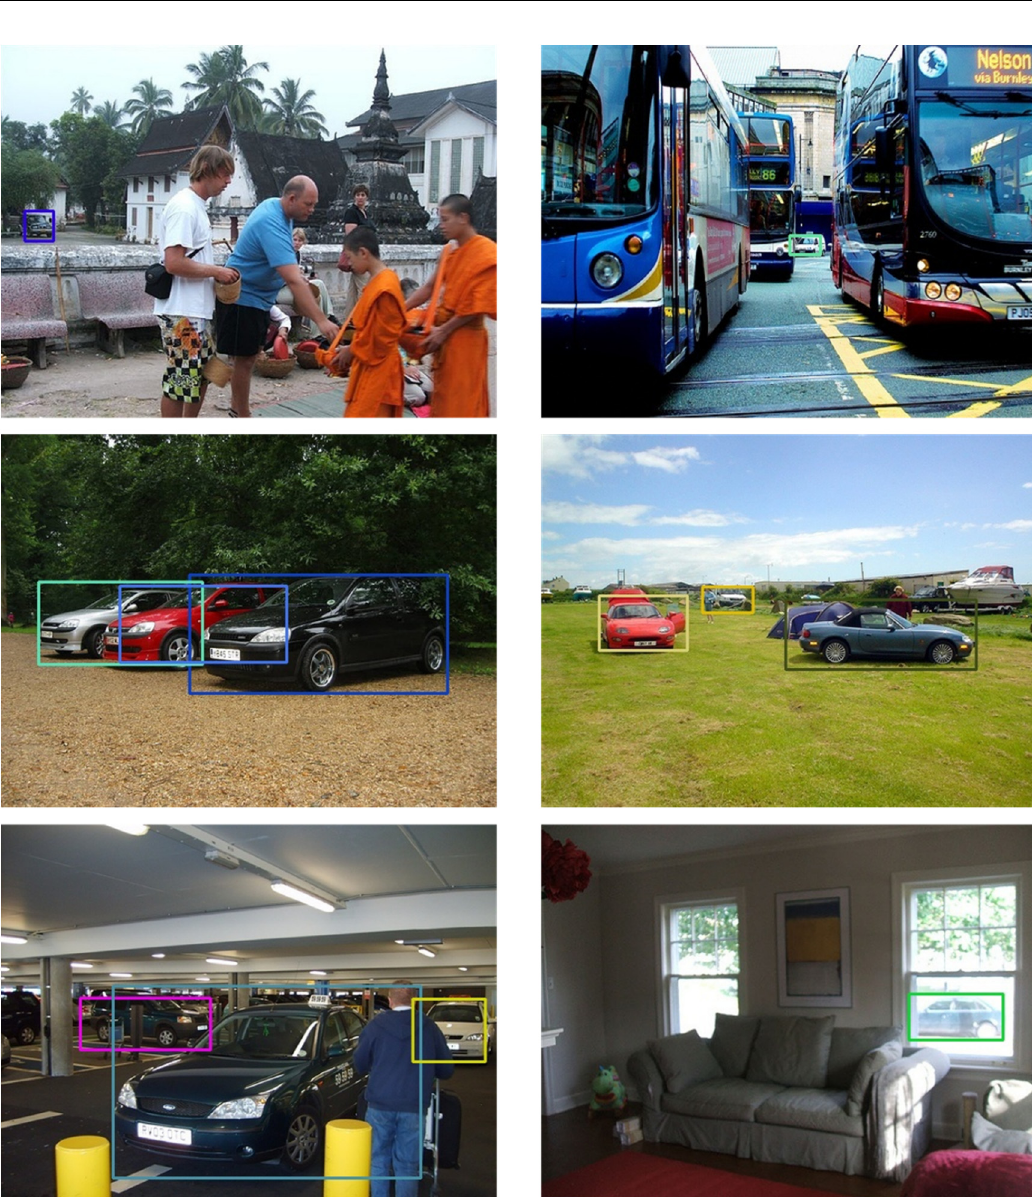
Figure 7. Detection examples on Pascal VOC 2007 car database. Our model can detect the cars that are occluded, located near the border or hidden within other vehicles that are of analogous